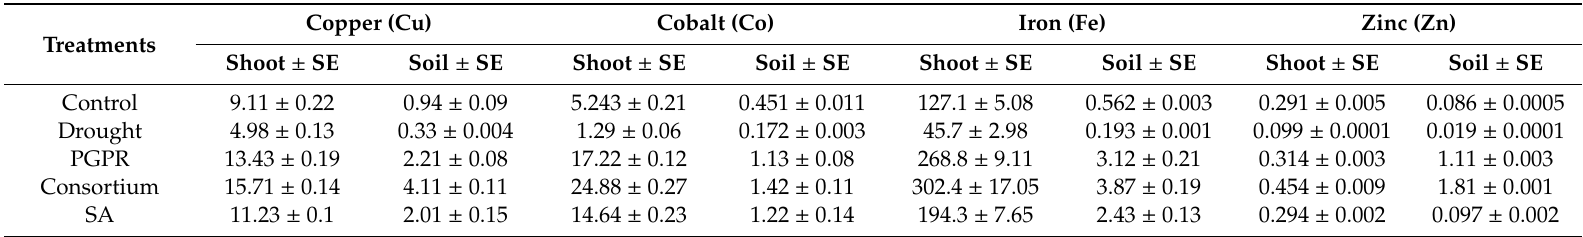
± SE-represents standard error values. Table 4. Micronutrient accumulation (mg / kg) in the shoot and rhizosphere of tolerant variety grown under rainfed conditions. Treatments